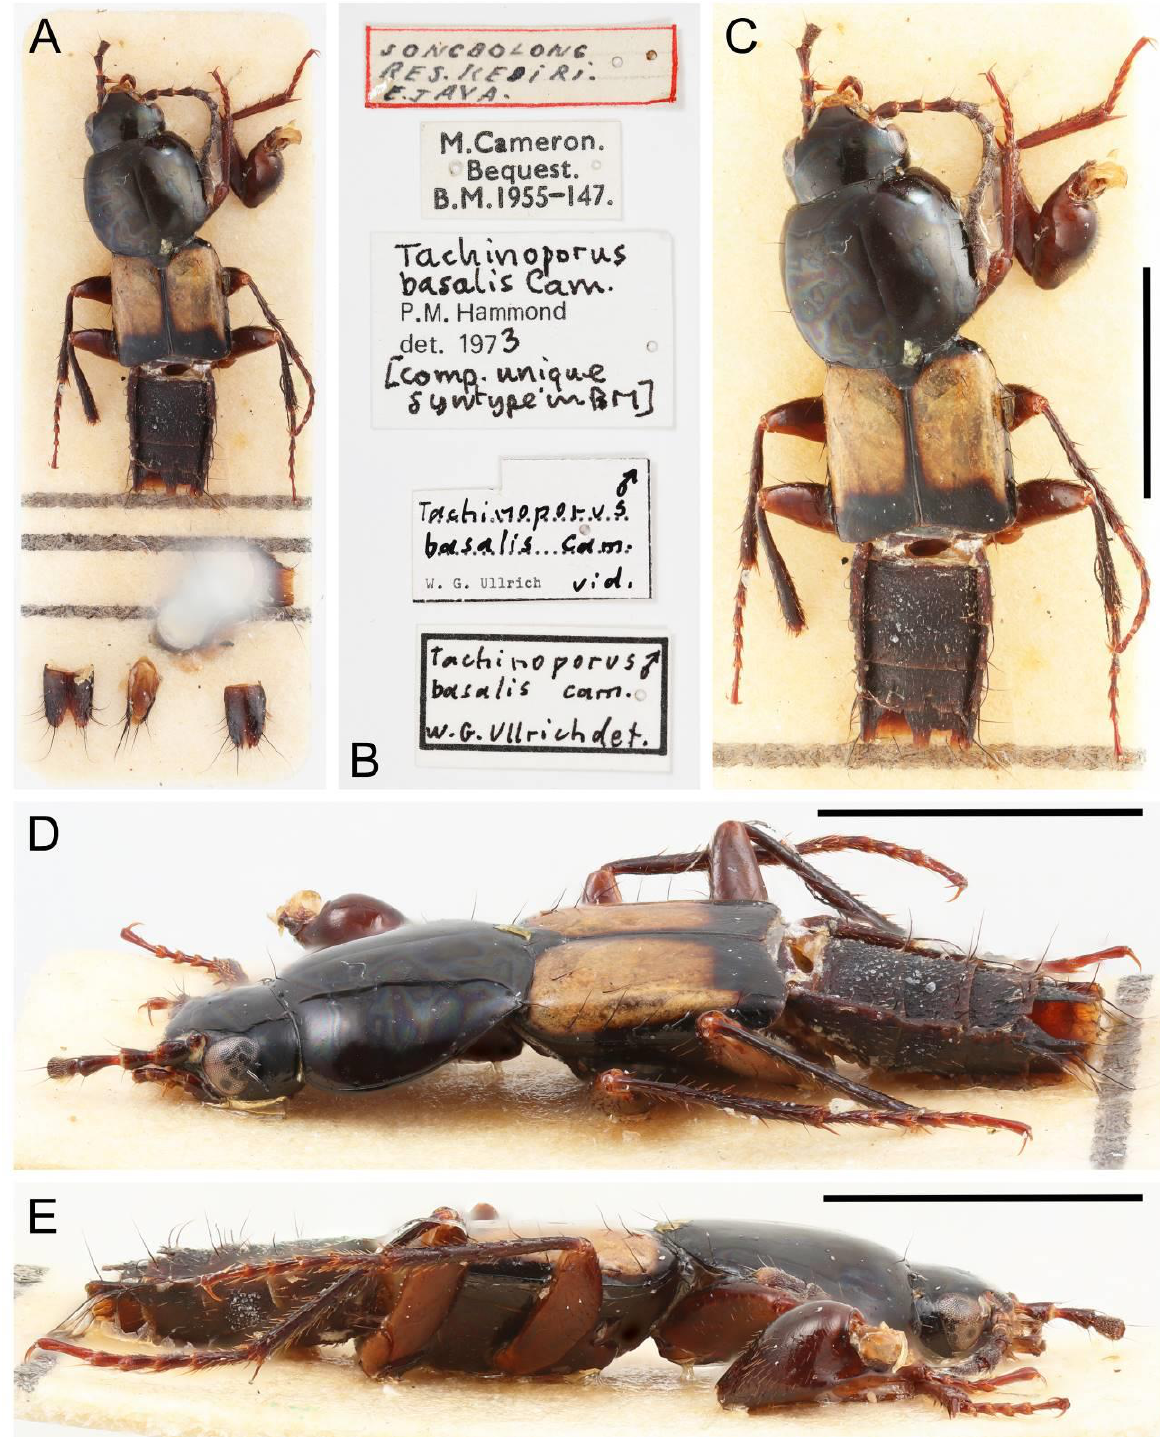
Figure 36. Photographs of Vatesini ( Tachinoporus basalis , male). ( A ) habitus with dissected body parts glued to the paper card, dorsal view. ( B ) labels. ( C ) habitus, dorsal view. ( D ) habitus, dorsolateral view. ( E ) habitus, lateral view. Scale bars: 2.0 mm ( C – E